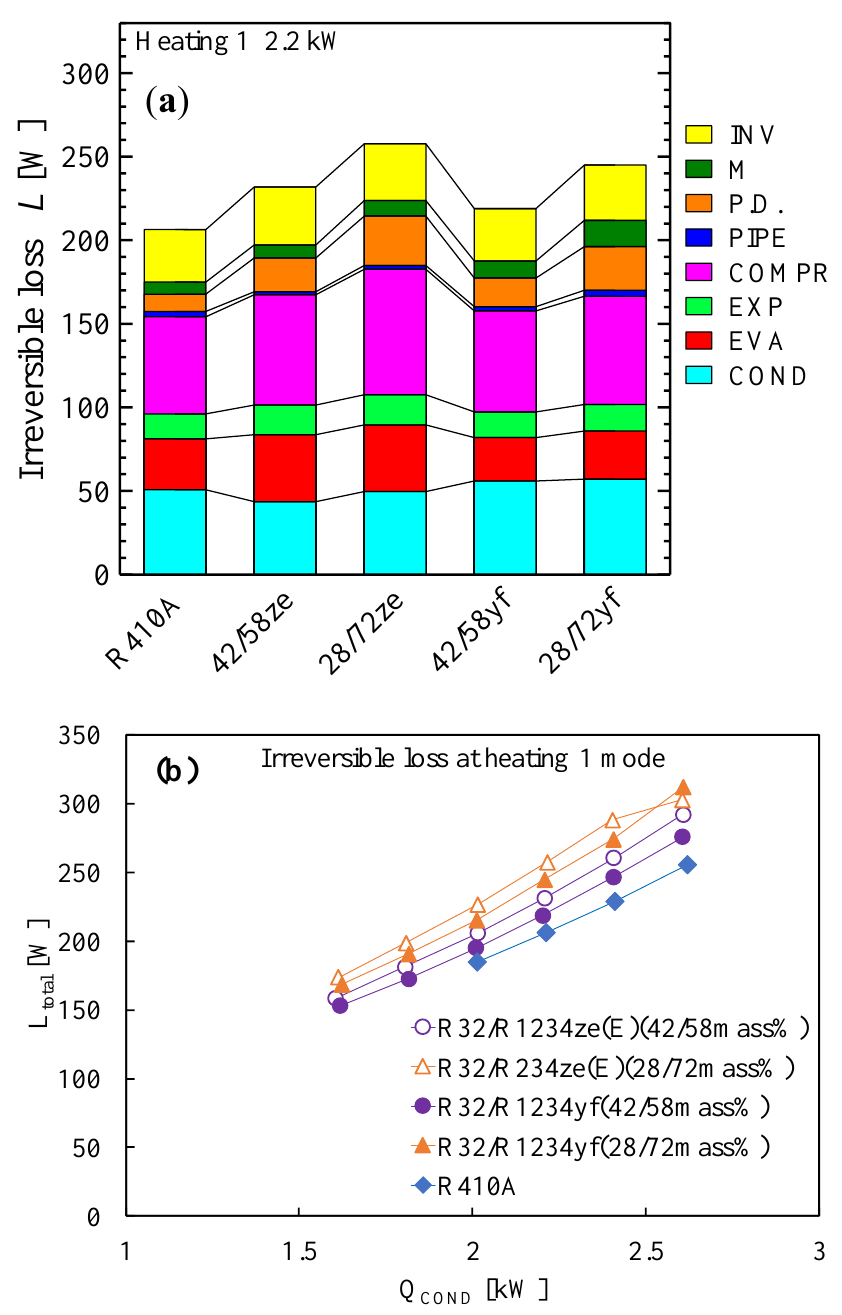
Figure 7. Irreversible loss of R32/R1234ze(E) and R32/R1234yf mixtures in a drop-in experiment. ( a ) Irreversible loss in each component of the system. ( b ) Total irreversible loss for promising binary mixtures [59].